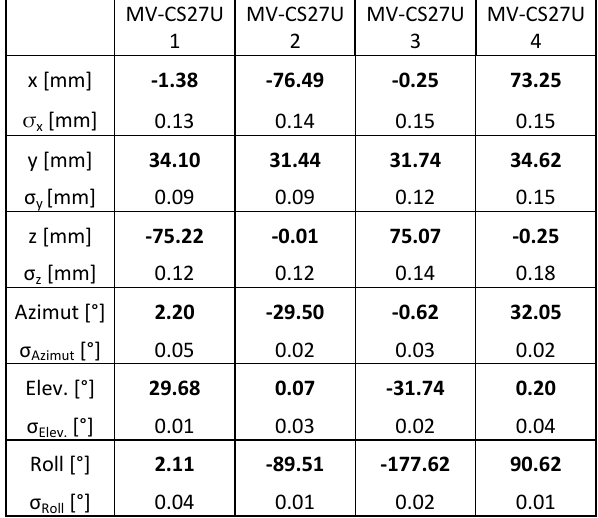
Table 1: Exterior Orientation of oblique looking cameras